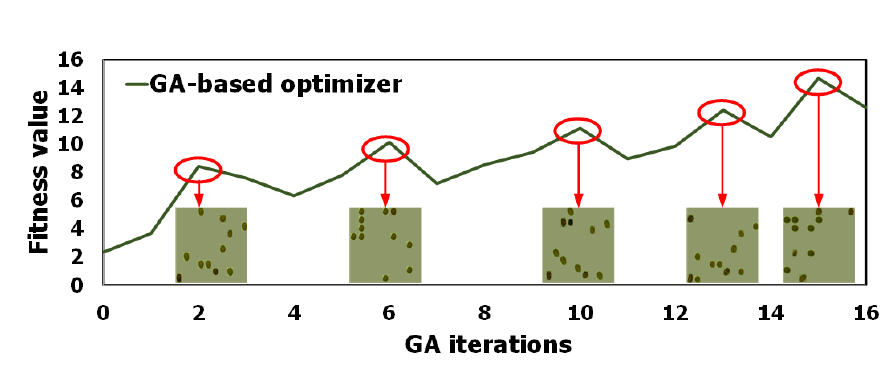
Figure 16. The fitness value as a function of the GA